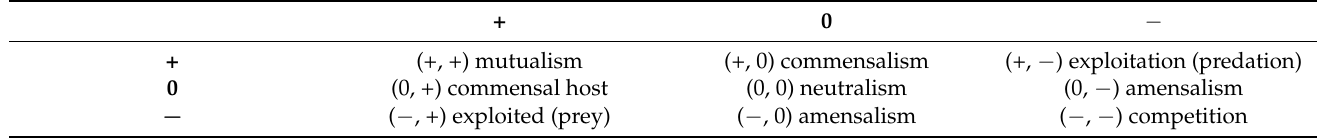
Table 3. Nine possible binary relationships with the ecological expressions of several generic types [60].